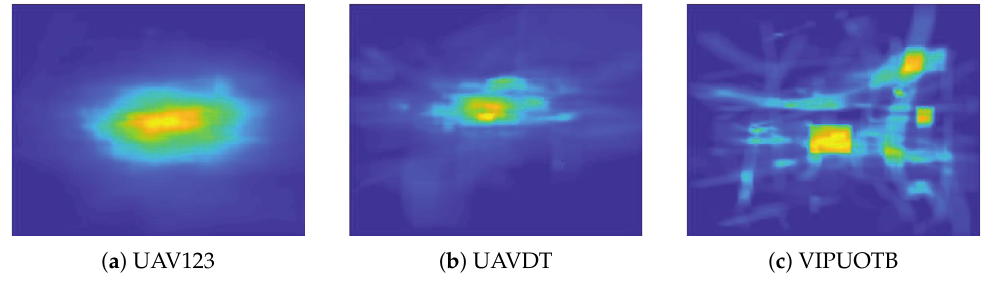
Figure 6. The location heatmaps of different